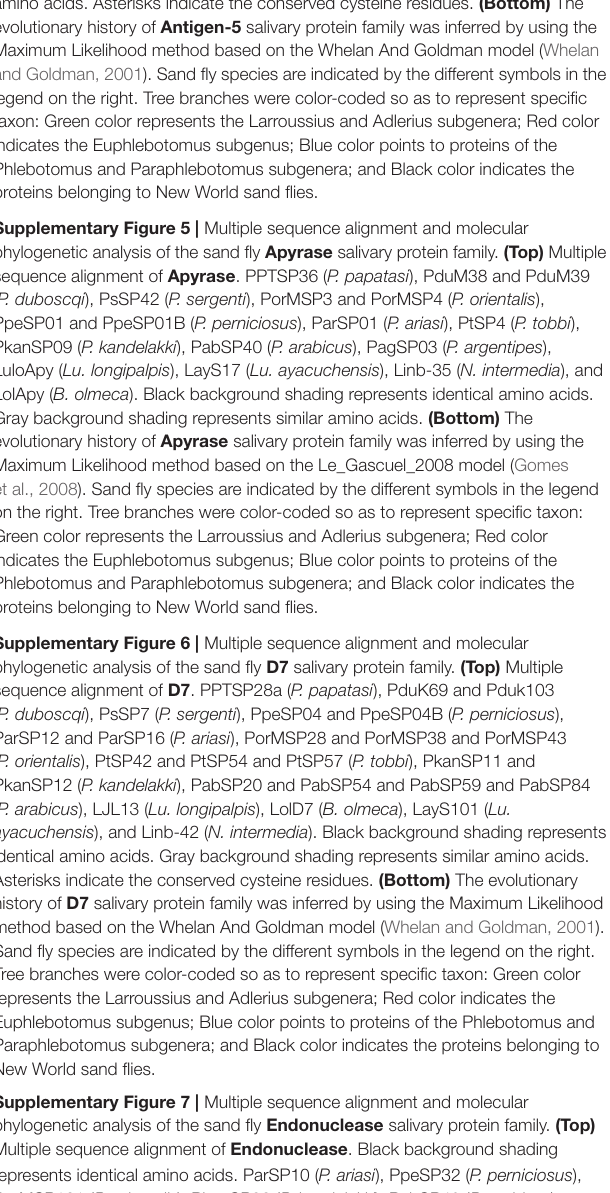
Frontiers in Cellular and Infection Microbiology |